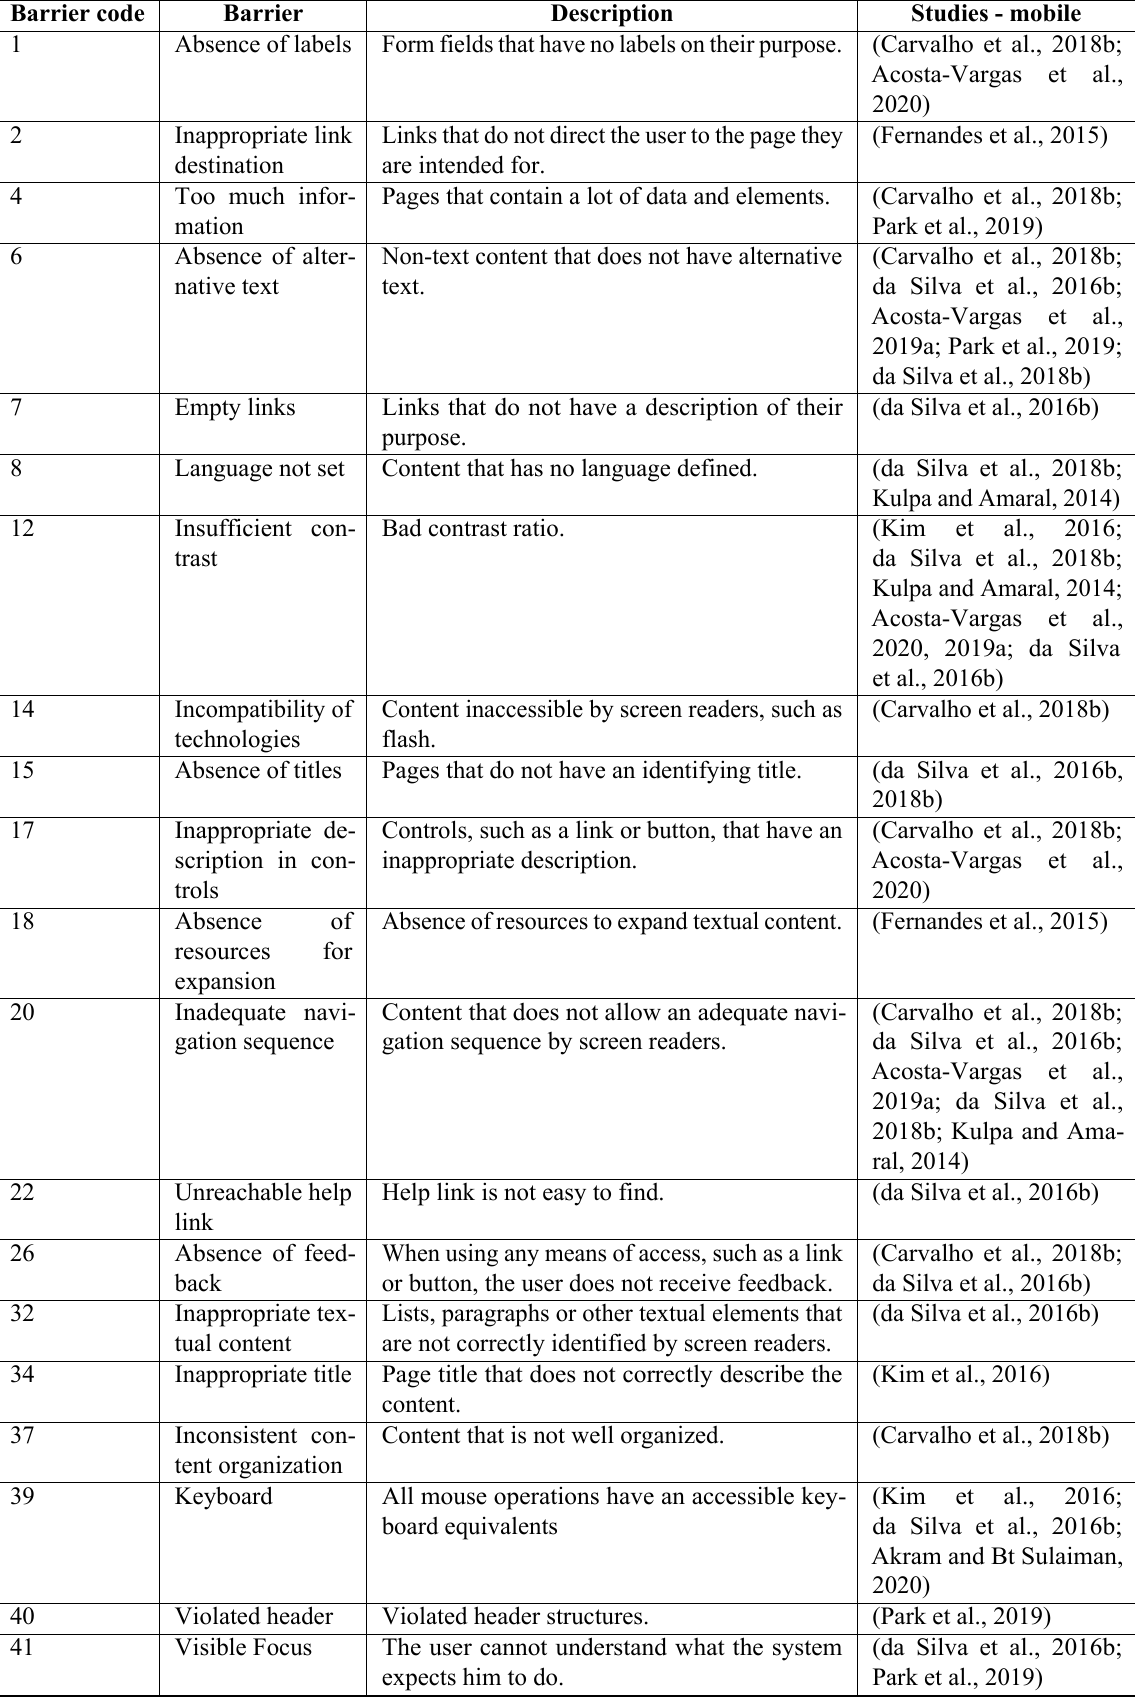
Table 15. Accessibility barriers encountered on mobile apps by user evaluations Barrier code